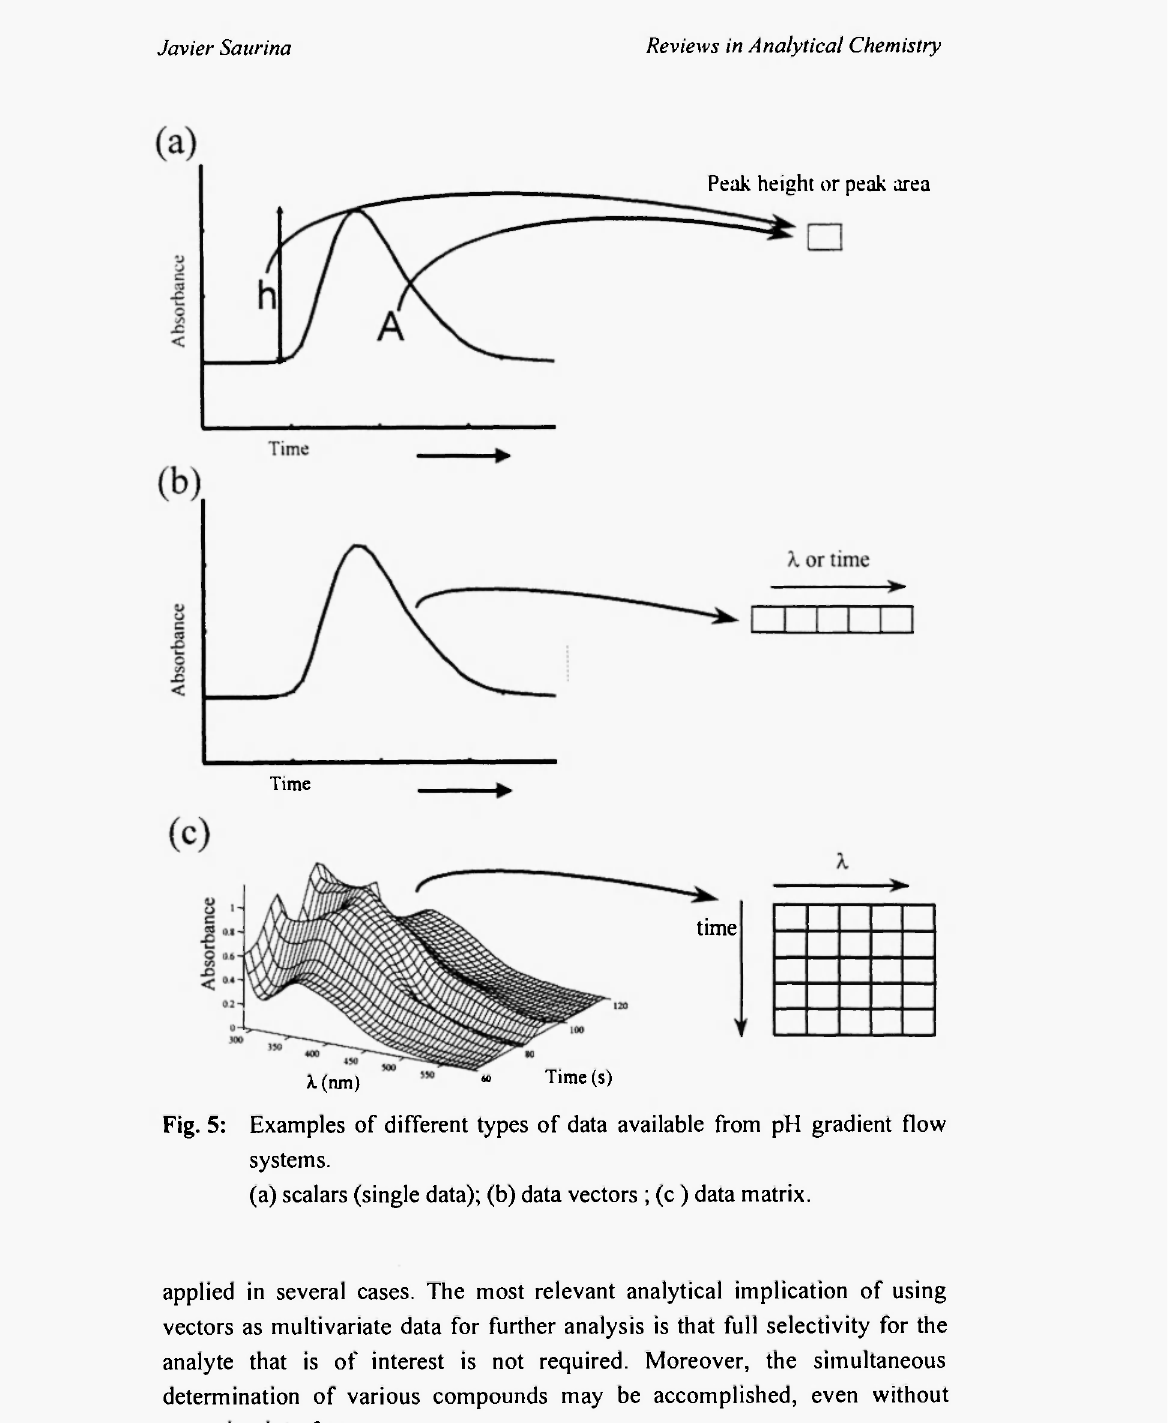
Fig. 5: Examples of different types of data available from pH gradient flow systems. (a) scalars (single data); (b) data vectors ; (c) data